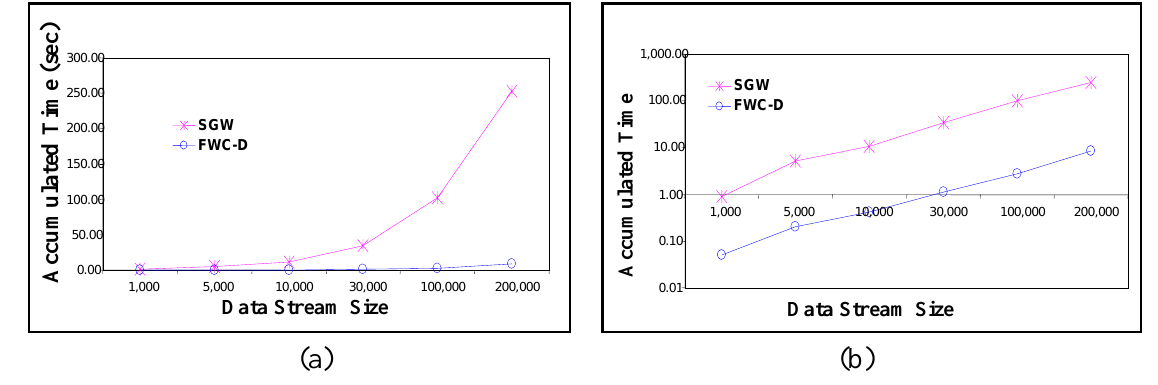
Figure 10. Accumulated execution time of the Embedding algorithm. ( a ) Linear Scale ( b ) Logarithmic